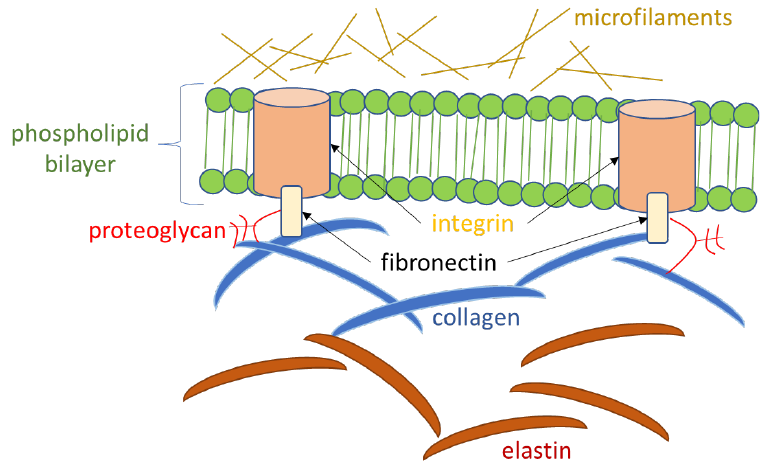
Figure 4. Components of the extracellular matrix (ECM).